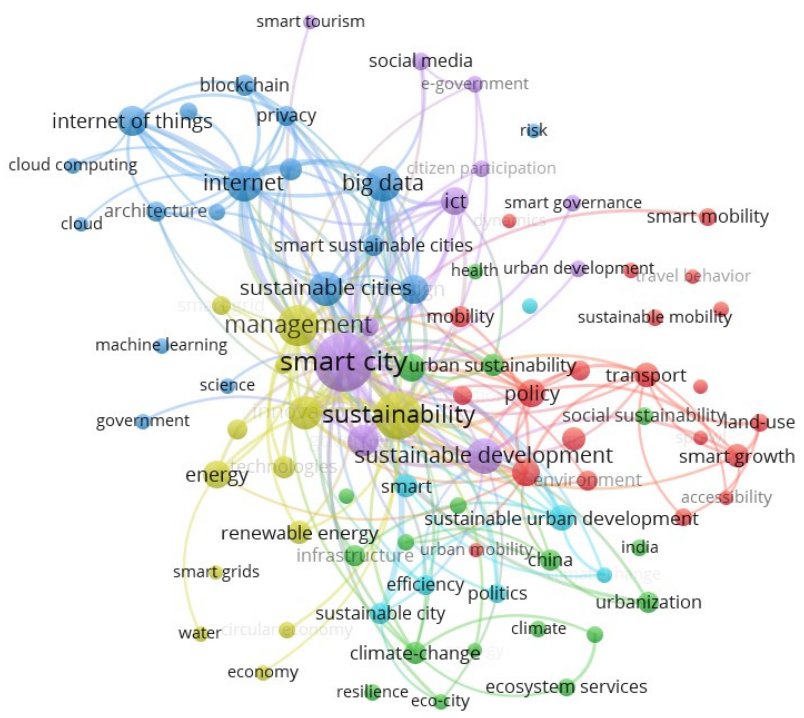
Figure 2. Co-occurrences of keywords ‘smart’ and ‘sustainable’ refined by ‘city’; 1000 most cited papers published in Web of Science 2015–2020; see Appendix A.2 for details.